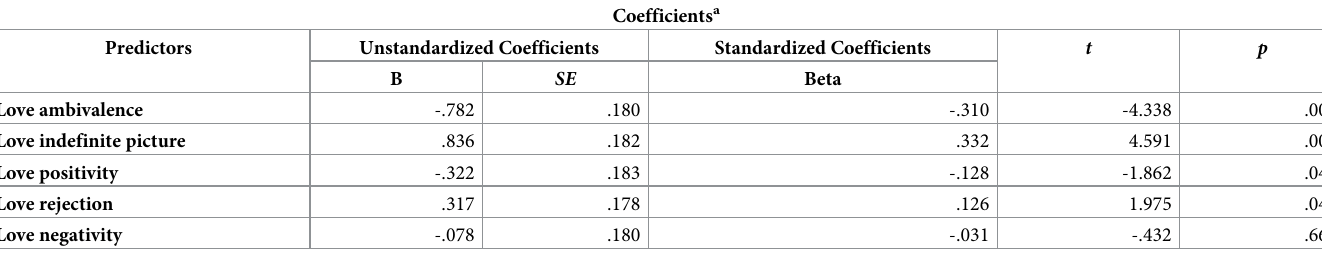
Table 6. Love script: Multiple regression analysis; script’ factors predict